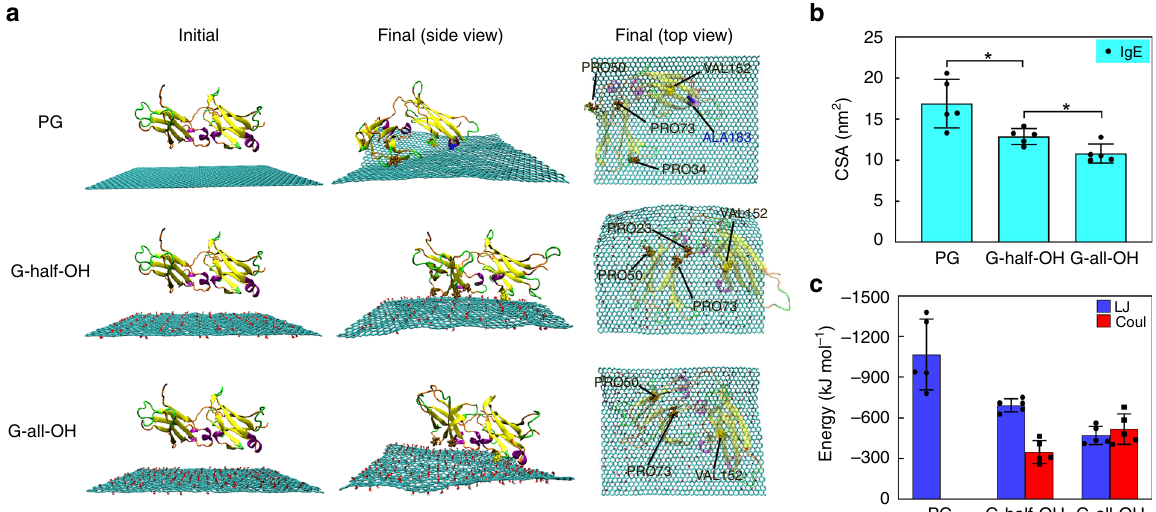
Fig. 3 The simulation results of the interaction of IgE with the graphene sheet. a Typical snapshots of the initial and fi nal structures of the adsorption of IgE onto the sheet (cyan) with different surface modi fi cations. From the side and top views, hydrophobic residues within 0.5 nm distance from the sheet surface are represented as CPK spheres. Water molecules and ions are omitted for clarity. b , c The contact surface area (CSA) and the Lennard-Jones (LJ) and Coulomb (Coul) interaction energy between IgE and the graphene with different surface modi fi cations, respectively. Data are presented as mean ± s.e.m. ( n = 5). p Values were calculated using multiple t tests (* p <